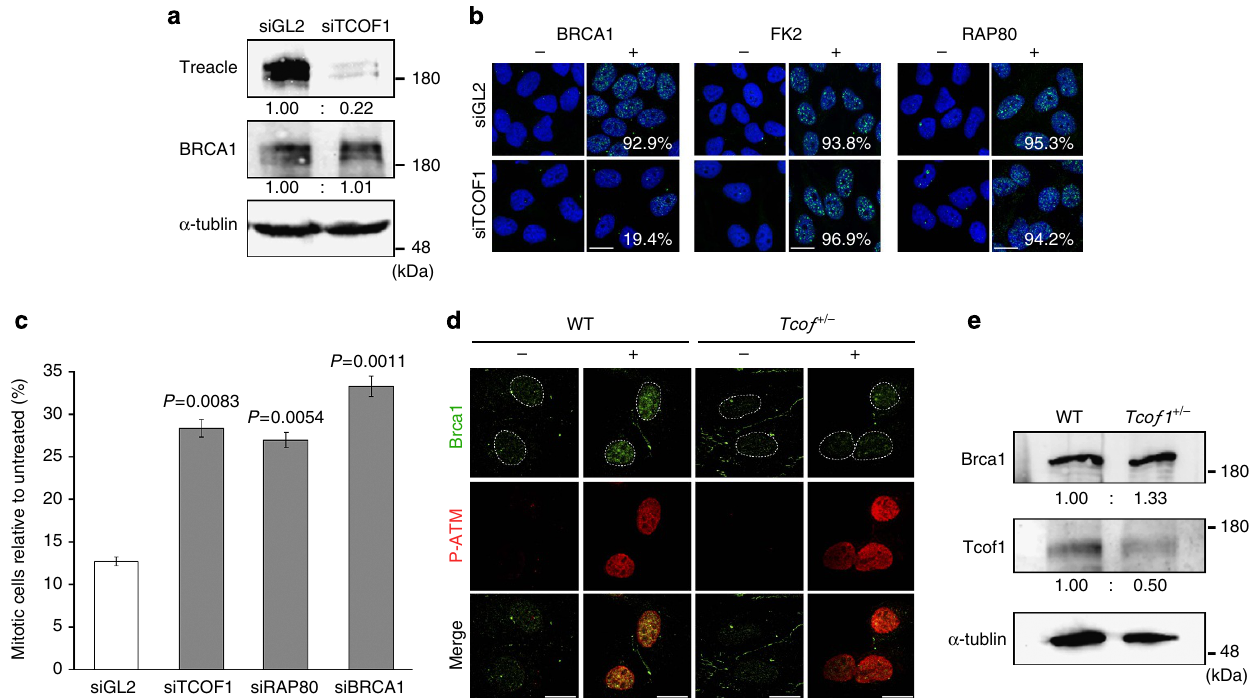
Figure 4 | Loss of TCOF1 leads to mislocalization of BRCA1. ( a ) Knockdown efficacy of siRNA against TCOF1 (siTCOF1) was analysed by western blotting with indicated antibodies. Signals were normalized to a -tubulin signals. Fold increase of relative values are presented. ( b ) DNA damage-induced foci formation in Tcof1 knockdown cells was analysed by immunofluorescence using indicated antibodies. The percentage shown in each figure was calculated by counting the number of cells having more than 10 DNA damage-induced foci in 1,000 cells. Scale bar, 10 m m. ( c ) Relative increase of G2/M phase cells after 3Gy irradiation was quantified by FACS analysis. Data are mean ± s.e. from seven independent experiments. Statistical differences were assessed with Student’s t -test, and P values were shown. ( d ) BRCA1 foci formation in wild-type (WT) and Tco f 1 þ / (cid:2) MEF cells upon DNA damage ( þ ) was analysed by immunofluorescence using P-ATM and Brca1 antibodies. Non-treated MEF cells were used as control ( (cid:2) ). Scale bar, 10 m m. ( e ) Expression levels of Brca1 in wild-type (WT) and Tco f 1 þ / (cid:2) MEF cells were analysed by western blotting with indicated antibodies. Signals were normalized to a -tubulin signals. Fold increase of relative values are